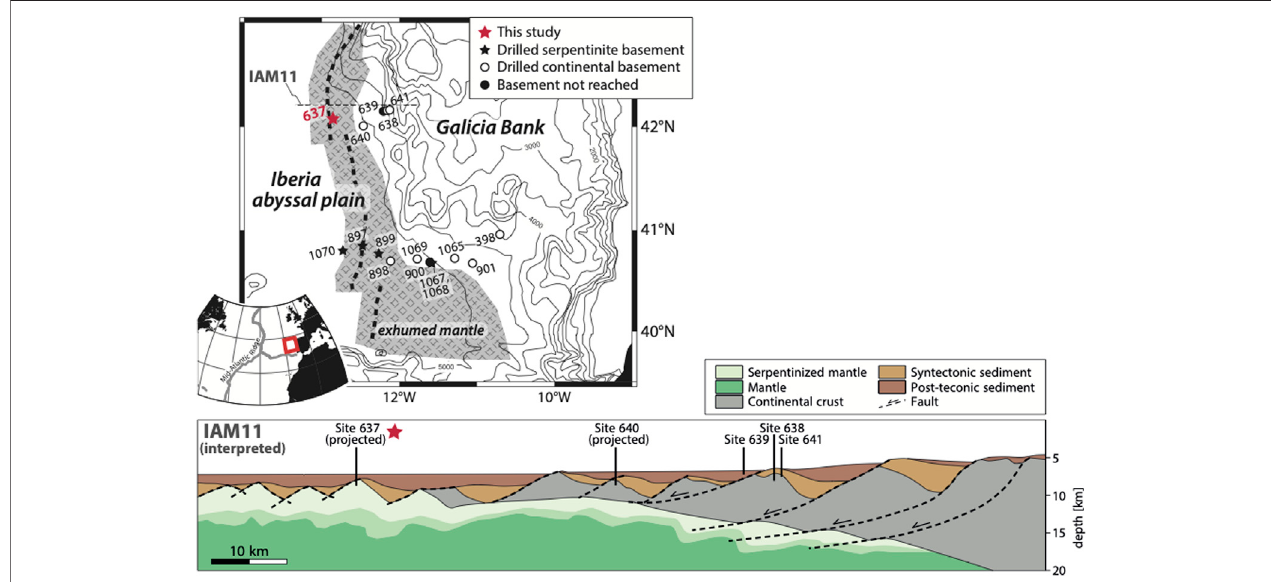
FIGURE 1 | Simpli fi ed map of and geological cross section across the West Iberia margin. Indicated are the approximate extent of peridotite exhumed to the sea fl oorandthedrillsitelocationsofODPLegs103,149,and173.SamplesinvestigatedhereoriginatefromSite637,whichrepresentsthemostlandwarddomainofthe OCT.Theotherdrillsitesarelocatedinstructuralpositionsfurtheroceanward.MapafterWhitmarshandWallace(2001)andKleinetal.(2015),structuralinterpretationof seismic line IAM11 after Ranero and Pérez-Gussinyé (2010).